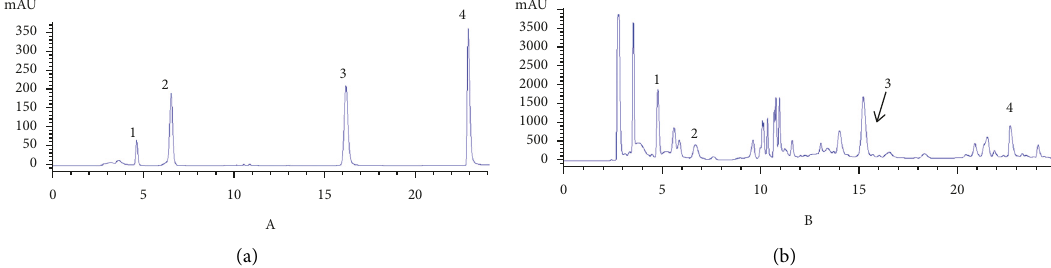
Figure 2: RP-HPLC chromatogram of 1-galloyl-glucose, GA, TGG, and EA (Note: A, reference product; B, test product; 1, 1-galloyl-glucose; 2, GA; 3, TGG; 4, EA).